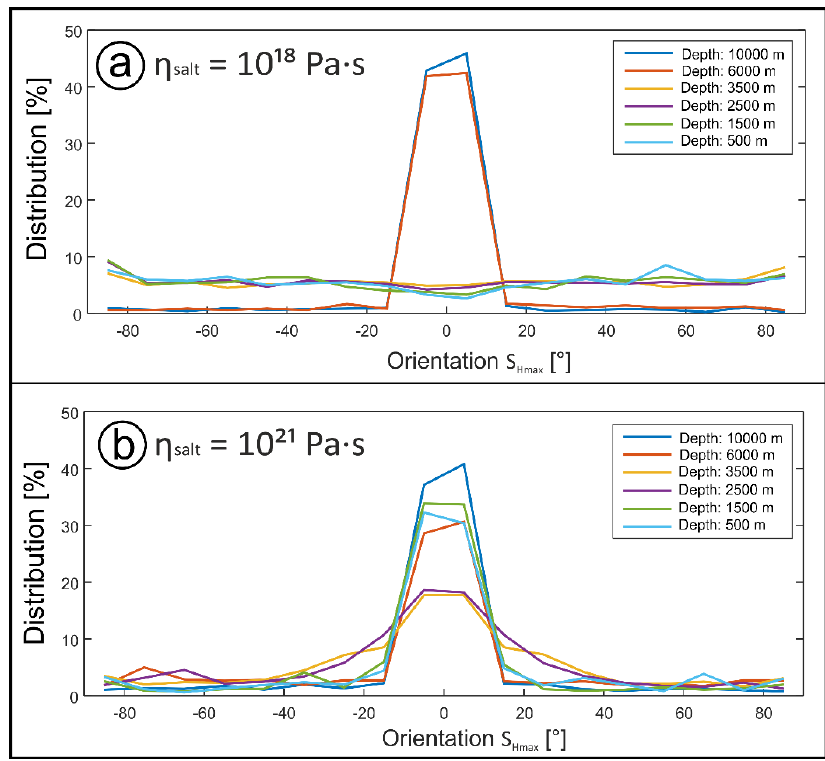
Figure 10 . Frequency distribution of S Hmax orientations at different depths and for different viscosities. An orientation of 0° corresponds to a N–S strike of S Hmax, which is the direction of shortening applied to the model boundary. Negative values indicate a counterclockwise rotation of S Hmax towards the west, whereas positive angles show clockwise rotation towards the east. ( a ) Salt viscosity is 10 18 Pa·s (Model B-04c). ( b ) Salt viscosity is 10 21 Pa·s (Model B-07a).